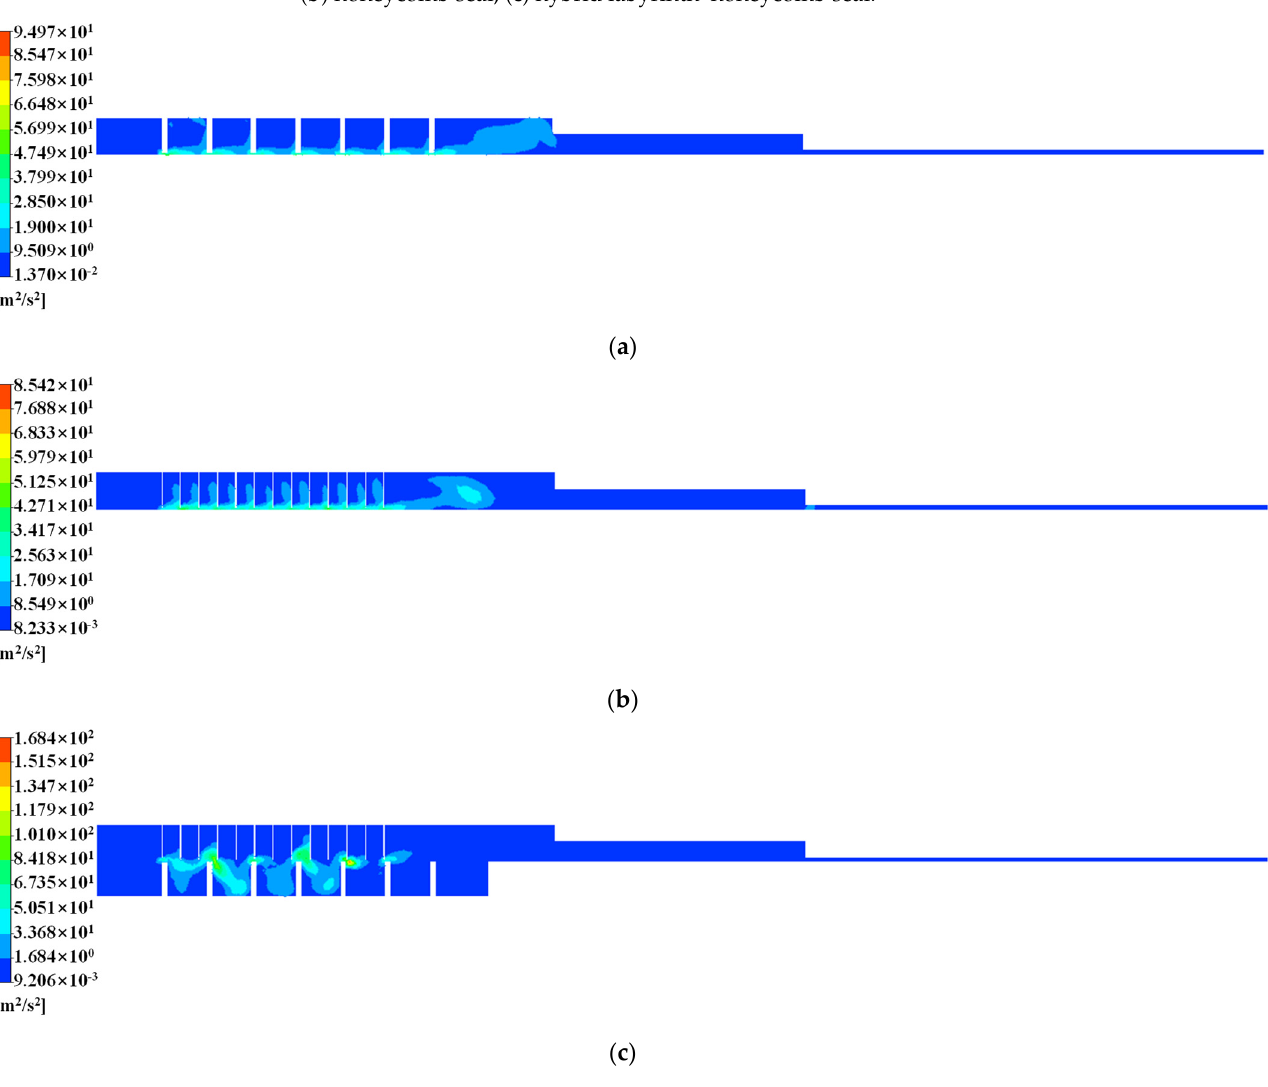
Figure 10. Turbulent kinetic energy diagram of three types of seals (REL = 0.1 mm). ( a ) Labyrinth seal; ( b ) honeycomb seal; ( c ) hybrid labyrinth–honeycomb seal.